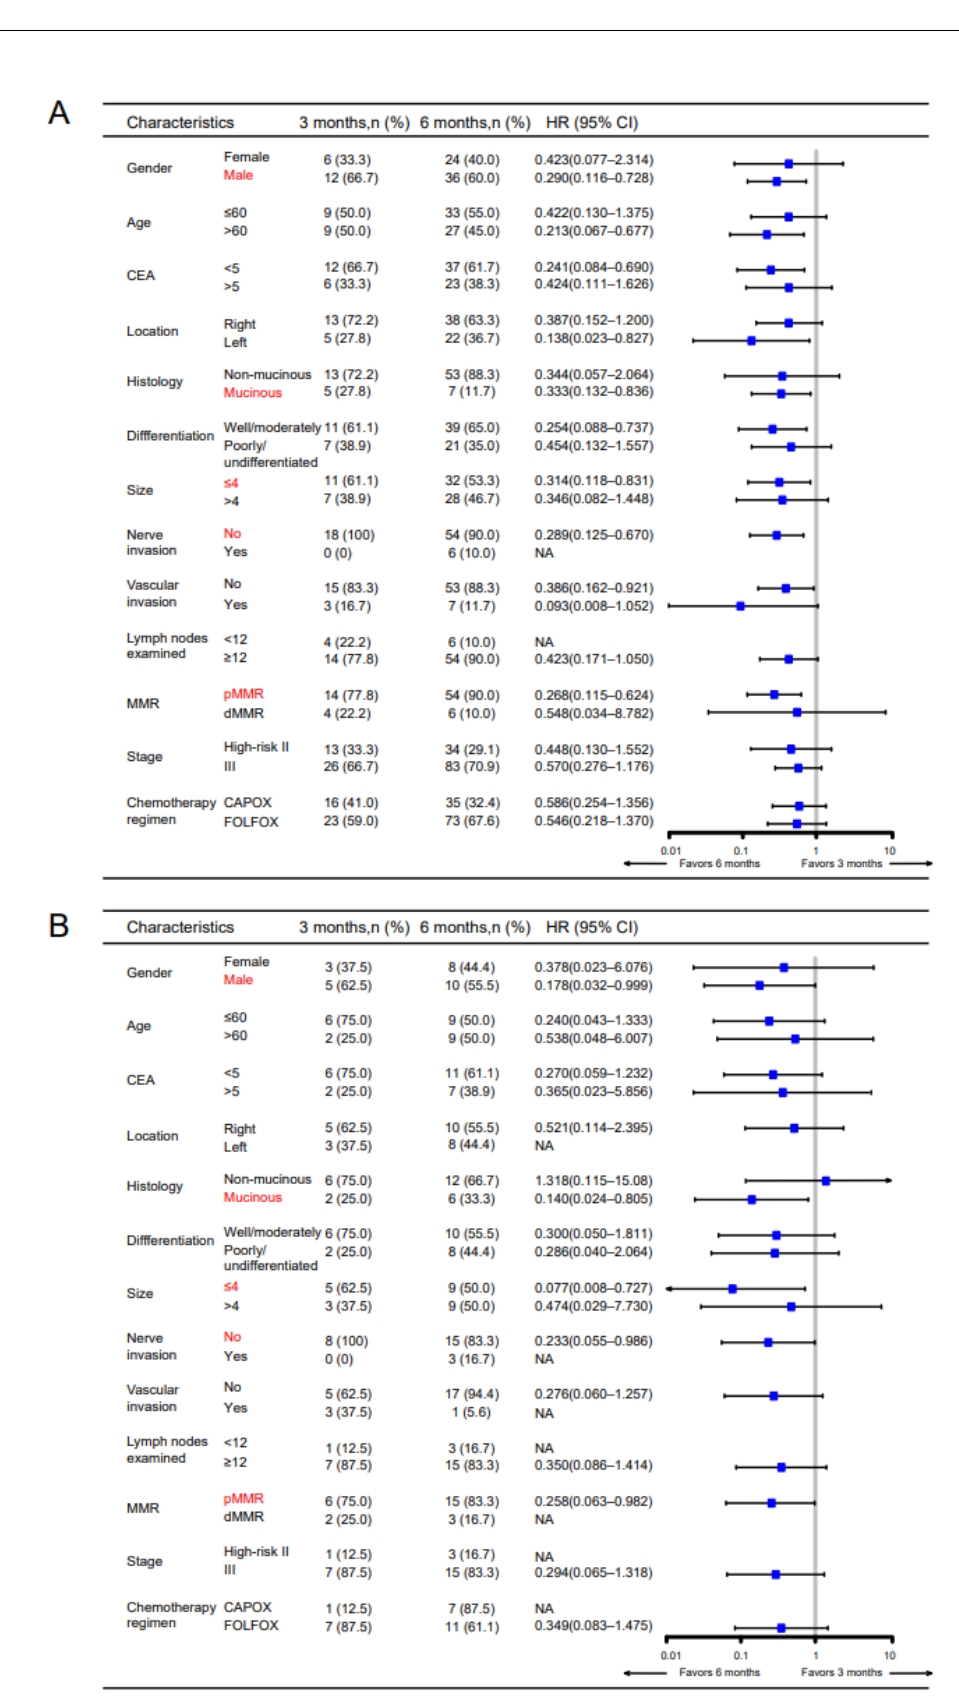
Figure 3. Subgroup analysis of high-risk stage II and stage III CC patients receiving adjuvant chemotherapy. Forest plot for primary cohort ( A ) and validation cohort ( B ). Groups with statistical significance for both cohorts were